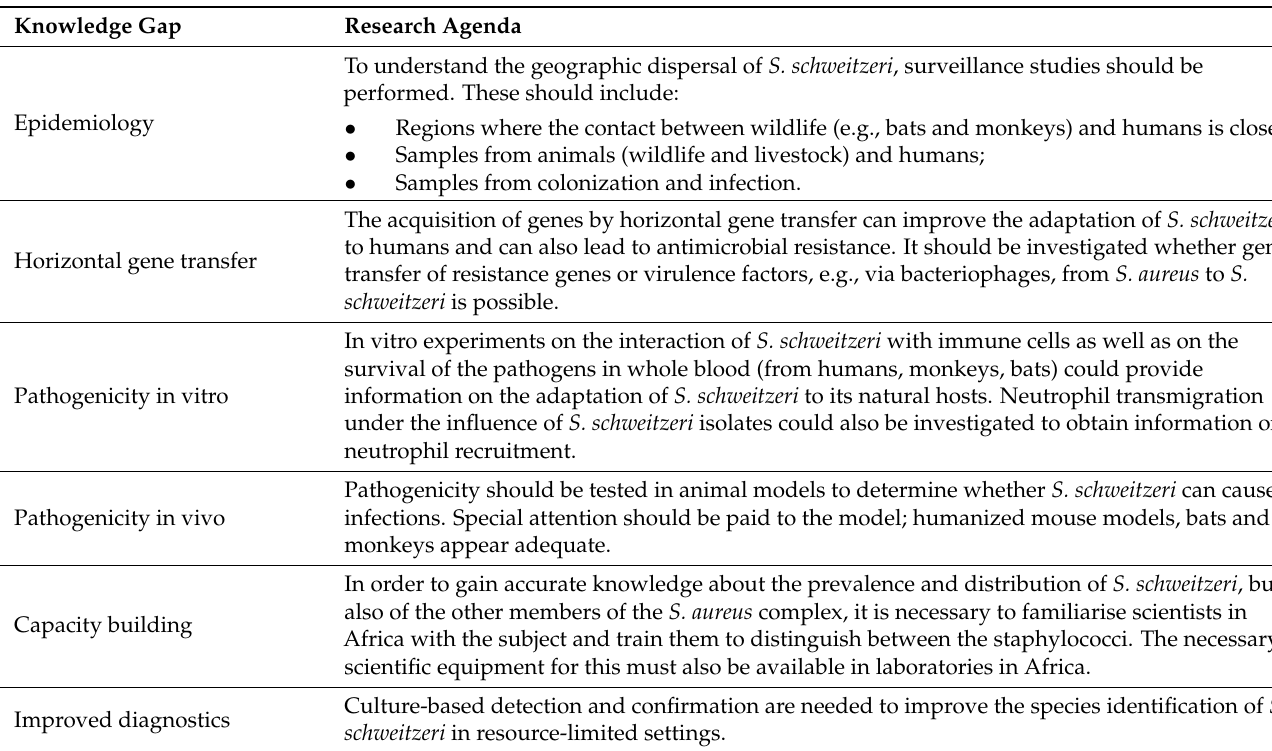
Table 2. Knowledge gaps and suggestions for future research on S. schweitzeri